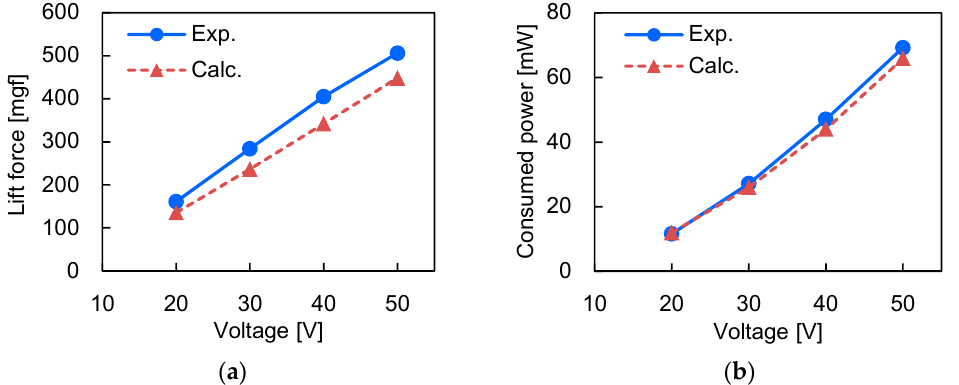
Figure 16. Relationship between applied voltage amplitude and ( a ) lift force; ( b ) consumed power of large-type actuator. The frequencies of the input signal in the experiment and calculation were 105 and 109 Hz, respectively.